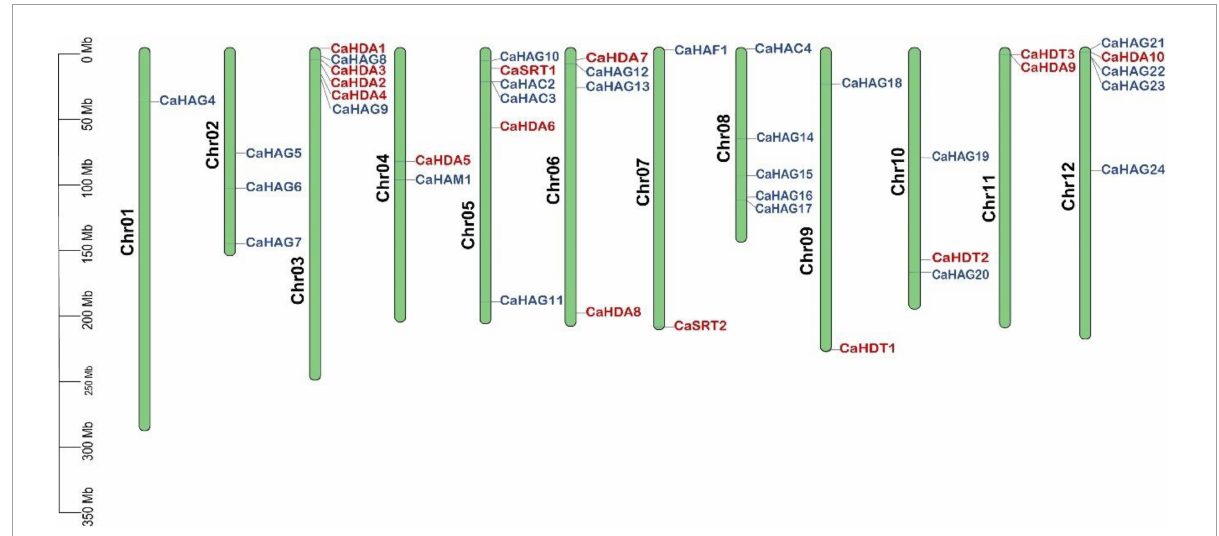
FIGURE2 Chromosomal location of CaHATs and CaHDACs gene family. Four genes ( CaHAC1 , CaHAG1 , CaHAG2, and CaHAG3 ) that did not assemble on the chromosome were omitted for display.